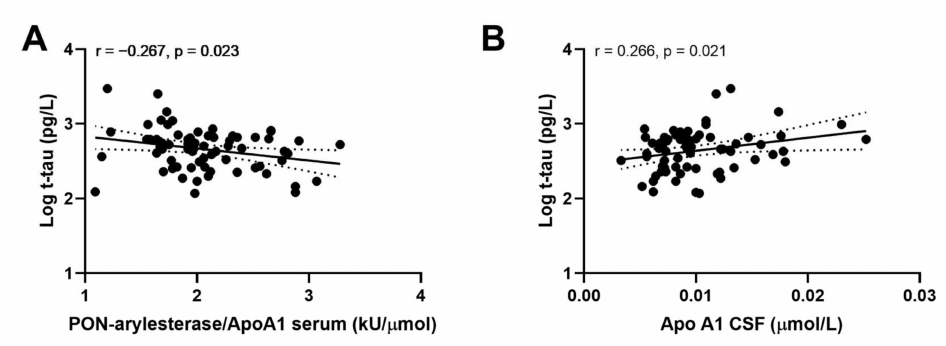
Figure 4. Correlation between CSF APO A1 and CSF log t-tau ( A ); serum PON-arylesterase / Apo A1 ratio and CSF log t-tau ( B ). Pearson’s correlation test was used to test the association between the variables of interest among subjects of ADC ( n = 71). Abbreviations: Apo A1, apolipoprotein A1, CSF, cerebrovascular fluid; VaD, vascular dementia; AD, Alzheimer’s disease; PON, Paraoxonase-1